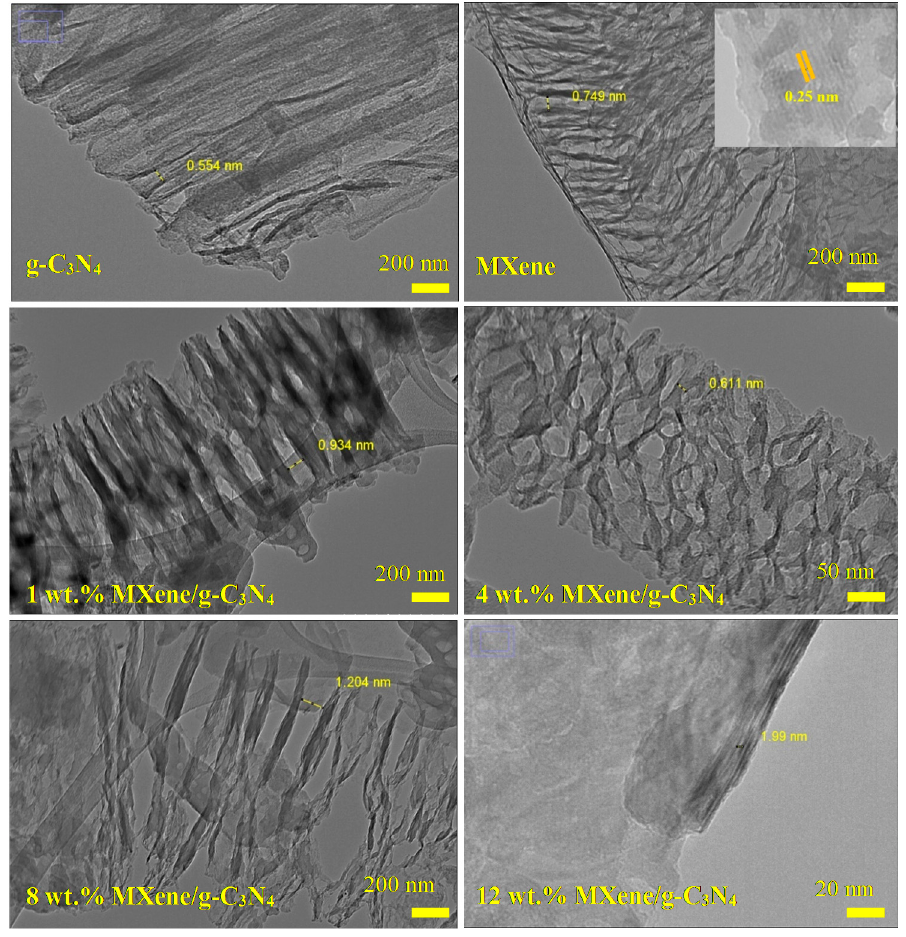
Figure 5. TEM images of the as-synthesized MXene/g-C 3 N 4 heterostructure photocatalysts.